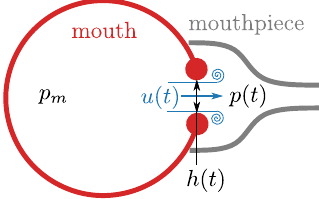
Figure 1. Schematic representation of the player ’ s mouth coupled to the mouthpiece of a brass